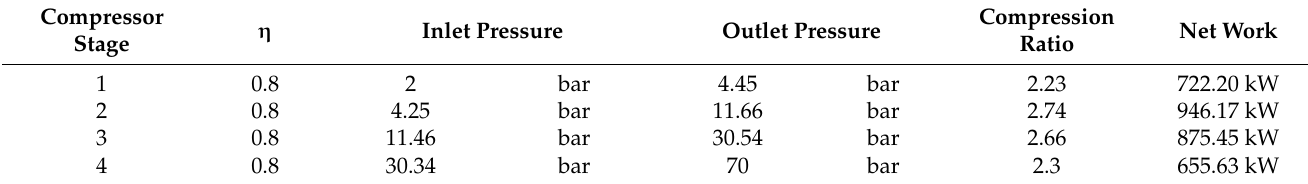
Table 3. Results for the compression